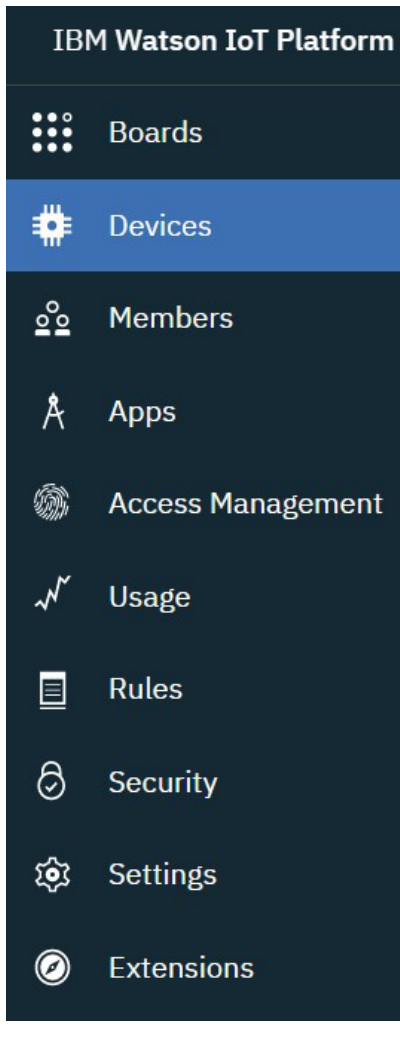
Figure 5. IBM Watson